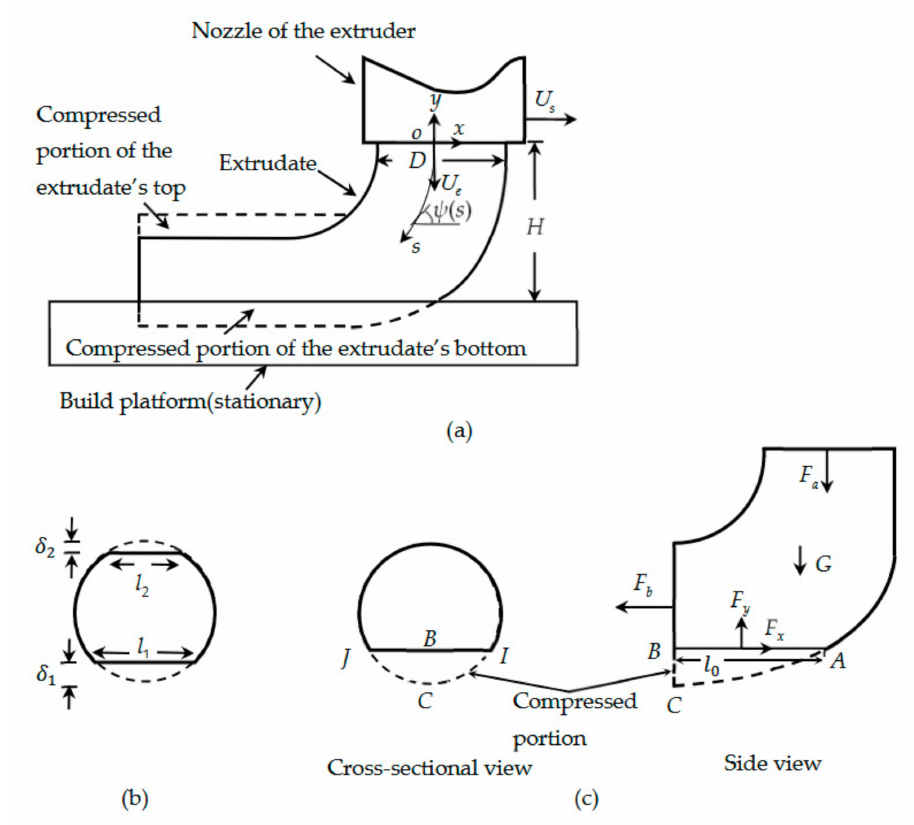
Figure 2. Deposition of an extrudate on a stationary build platform: ( a ) side view of the setup, ( b ) cross-sectional view of the compressed extrudate during the collision, and ( c ) free-body diagram of the extrudate